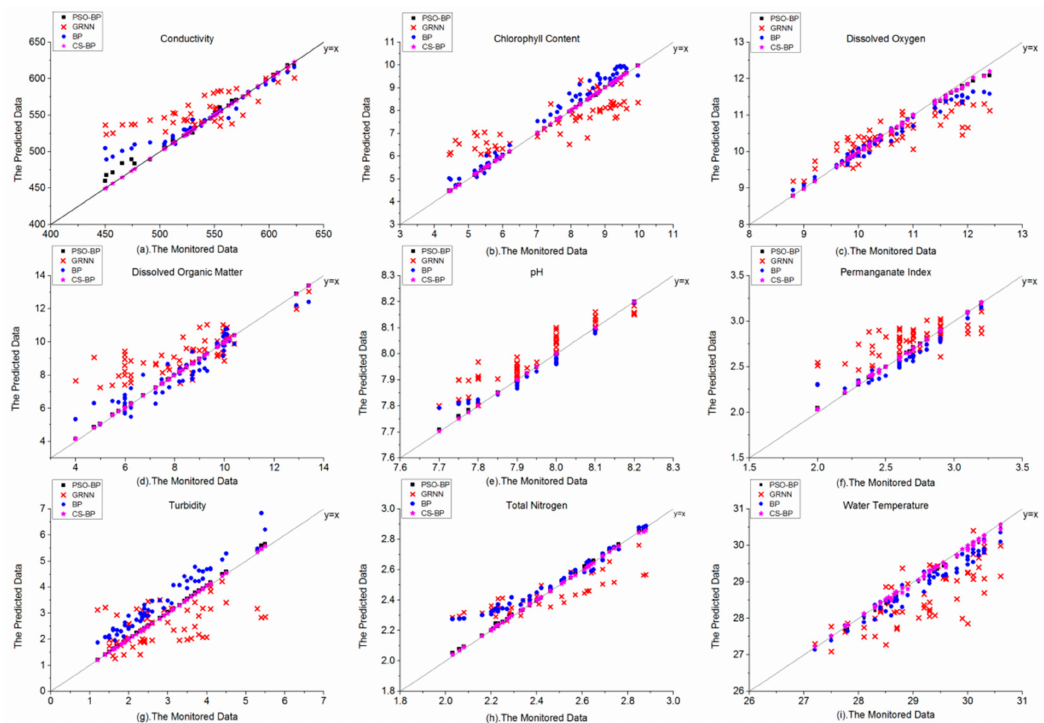
Figure 9. Comparison result of predicted and monitored data of water quality indicators of four models of part A in Scenario 3.